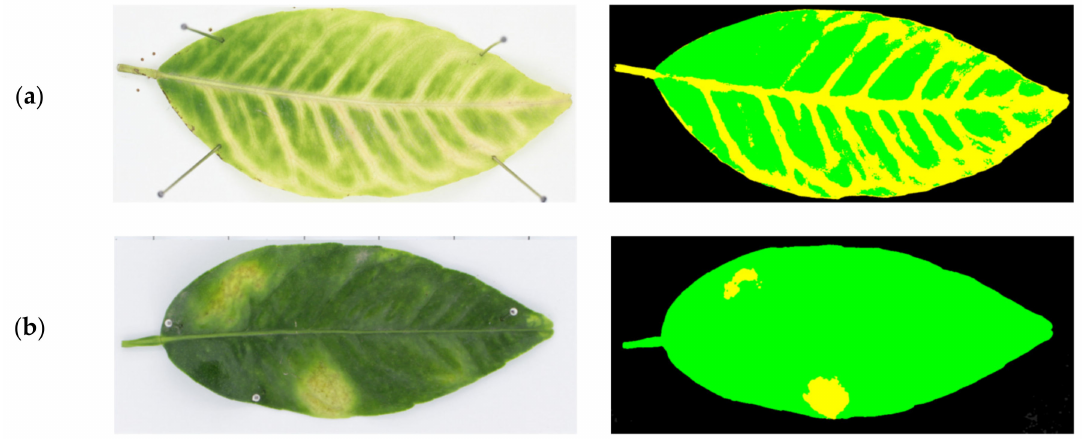
Figure 3. Examples of image segmentation of leaves. ( a ) Leaf with symptoms compatible with N deficiencies. ( b ) Leaf affected by T. urticae